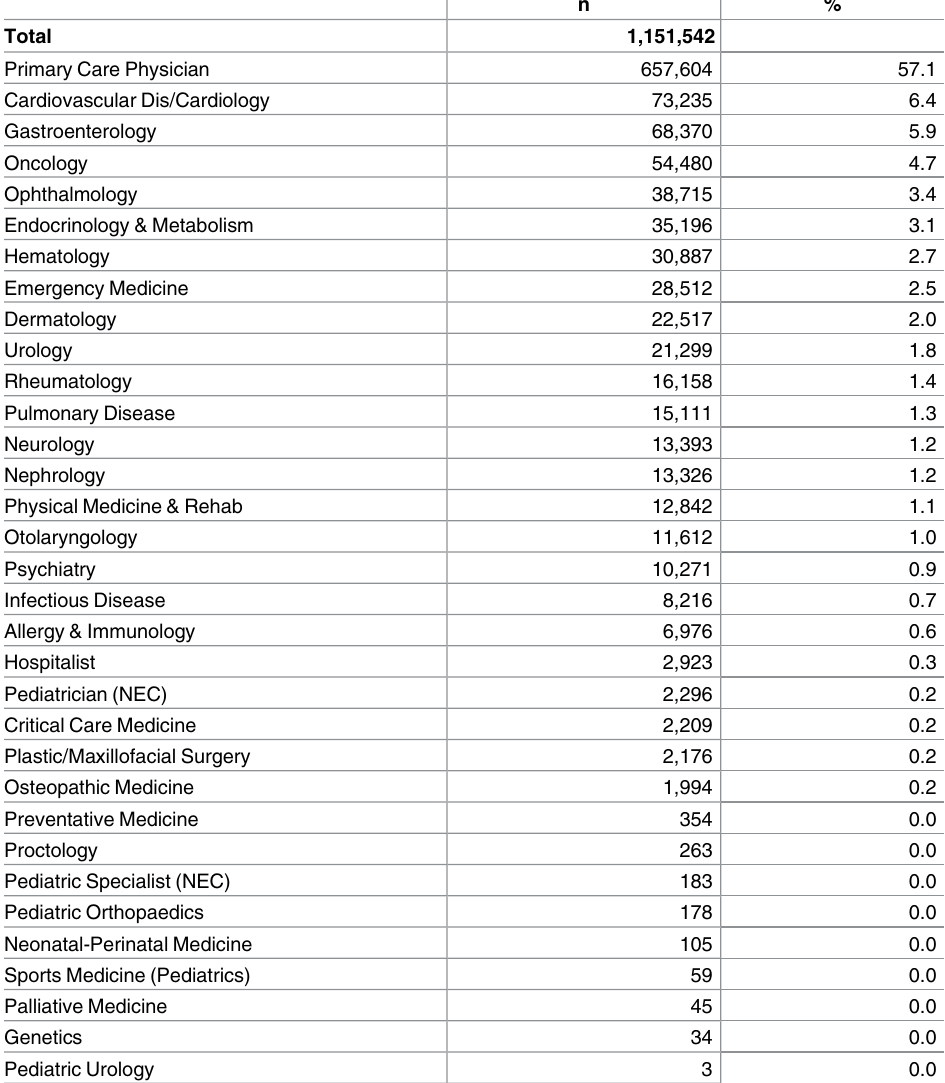
Table 2. Distribution of total physician encounters by specialties,